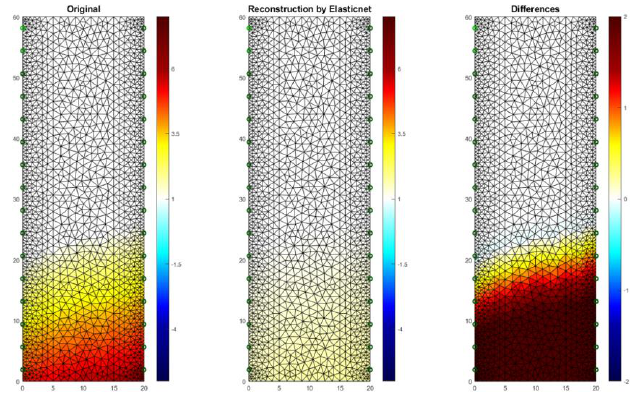
Figure 18. The result of ElasticNet moisture testing of the lightweight concrete block for the case of 2 × 16 electrodes.